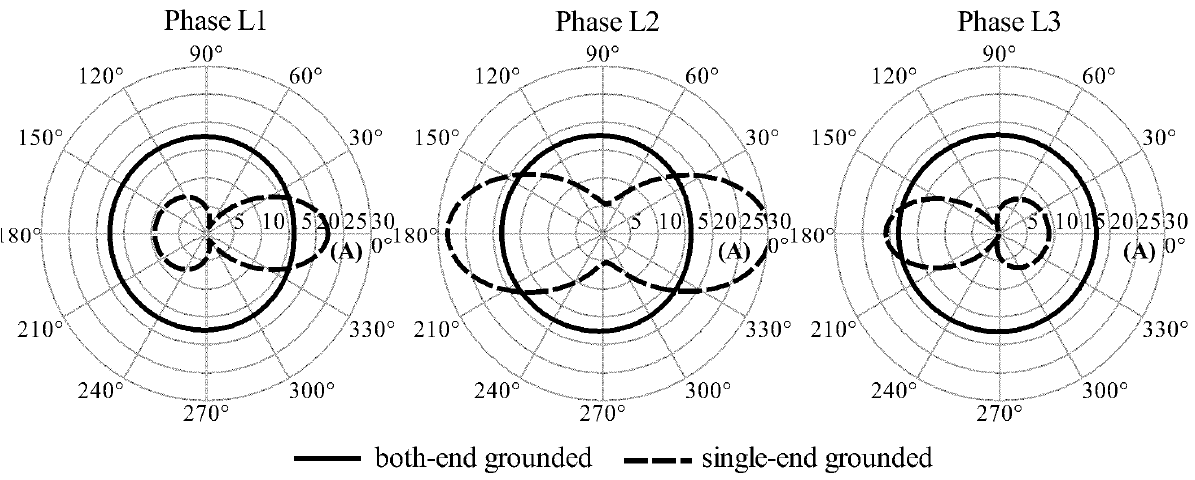
Figure 6. Distribution of the screen currents for both of the above mentioned screen (grounding and bonding)